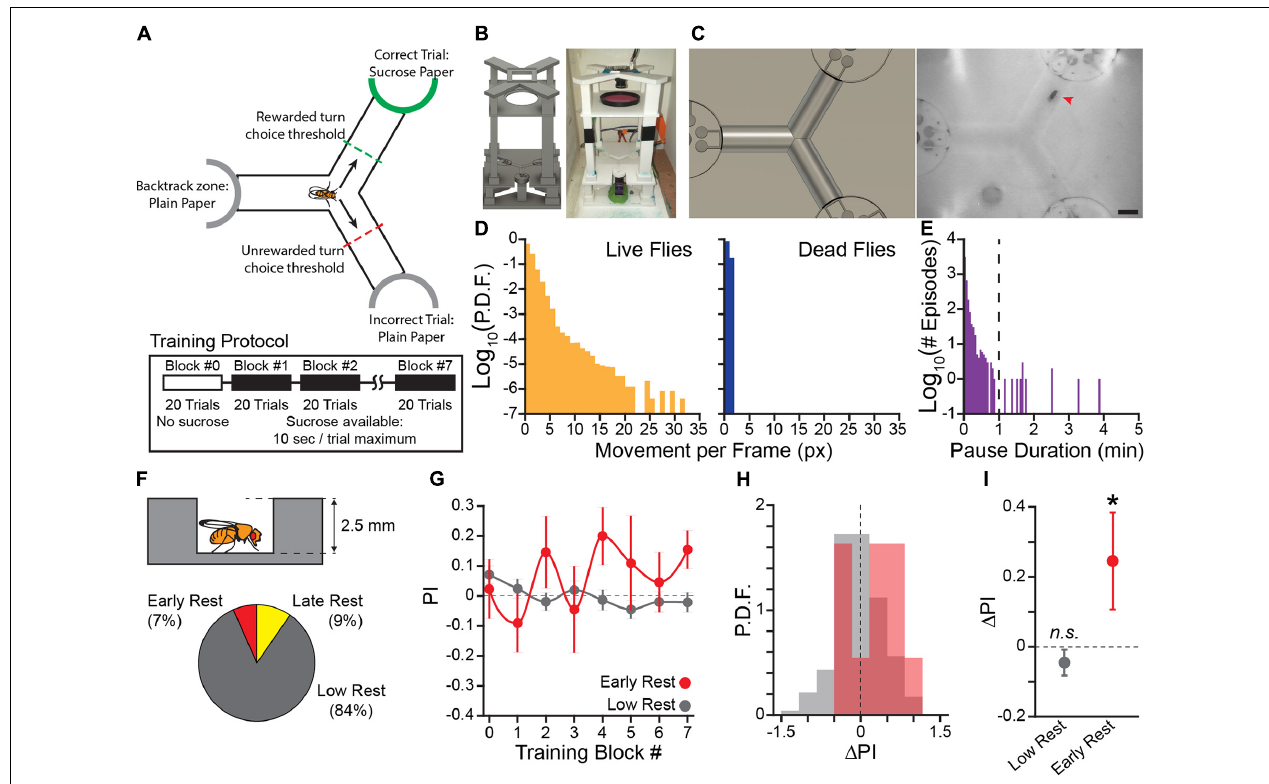
FIGURE 1 | Flies that rest learn the operant contingency in a novel sucrose seeking task. (A) Diagram of operant conditioning paradigm. Sucrose is presented at the end of the track in the reinforced direction. A trial is completed after the fly crosses the choice threshold leaving the center of the track. Each training block is 20 trials, reward presentation begins in training block #1. Sucrose is made available for 10 s following the fly crossing the choice threshold. (B) Rendering of the 3D model of the novel apparatus used for 3D printing ( Left ) and a photo of a fully assembled apparatus ( Right ). (C) Field of view of overhead camera in the 3D render ( Left ) and a video frame of a fly navigating the Y-Track ( Right ). Red arrowhead indicates the position of the fly. Scale bar: 5 mm. (D) Probability Distribution Function (P.D.F.) histogram of movement (in pixels) per frame (approx. 50 ms) for live flies ( Left ) and dead flies ( Right ). One pixel of movement is approximately 90 µ m. (E) Histogram of locomotor pause durations from 12 h recordings of locomotor behavior ( n = 2 flies, 4127 episodes). Dashed line indicates the 1 min threshold to distinguish short pauses from rest episodes. (F) Schematic of hallway geometry with representative fly for scale ( Top ), Fraction of flies with each rest phenotype ( Bottom ). (G) Mean turn direction Preference Index (PI) for each training block. Points plotted in color are flies with early rest (drowsy), points plotted in gray are flies with low rest (restless). (H) Probability Distribution Function (P.D.F.) histograms of change in turn preference index ( (cid:49) PI) between training block #1 and #7. Drowsy flies are plotted in red, restless flies are plotted in gray. (I) Mean (cid:49) PI of low rest and early rest flies. Error bars are standard error of the mean, n.s. : groups are not significantly greater than zero, * groups are significantly greater than